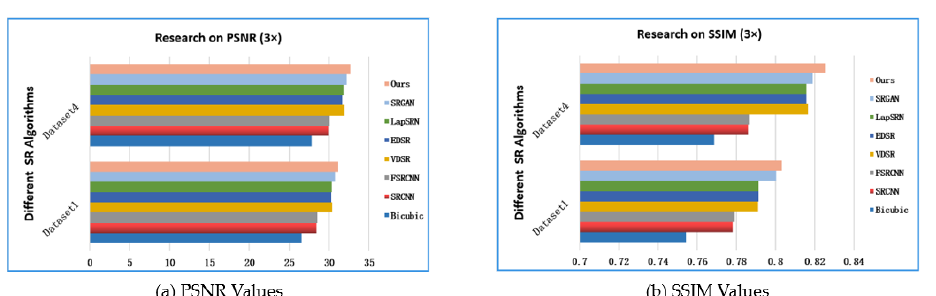
Figure 11. Compared PSNR and SSIM results with a 3× scale on Dataset 1and Dataset 4. Table 2. Average PSNR on Dataset 1, Dataset 2, Dataset 3, and Dataset 4 with different algorithms.